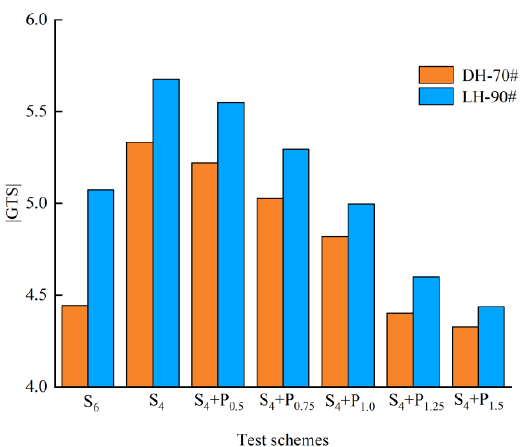
Figure 17. Effect of different PPA – SBS compound ratio on temperature sensitivity of asphalt.